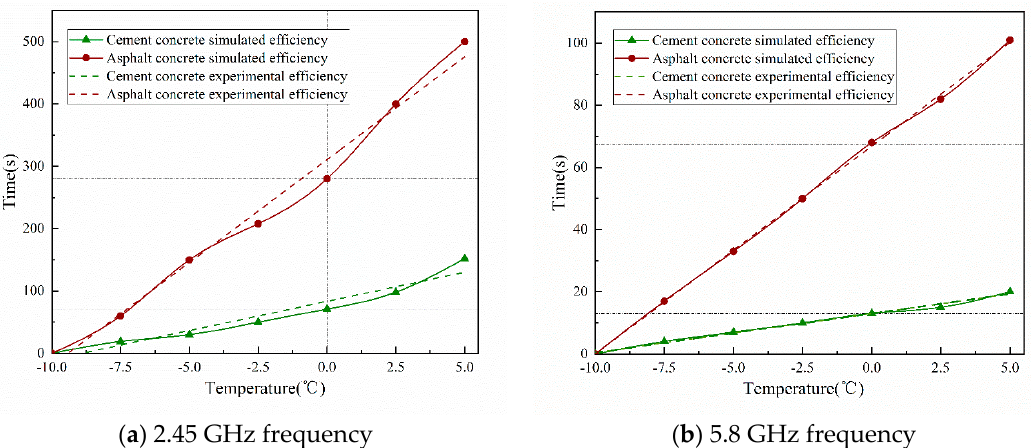
Figure 13. Comparison of deicing rates between indoor tests and simulations of different road materials.